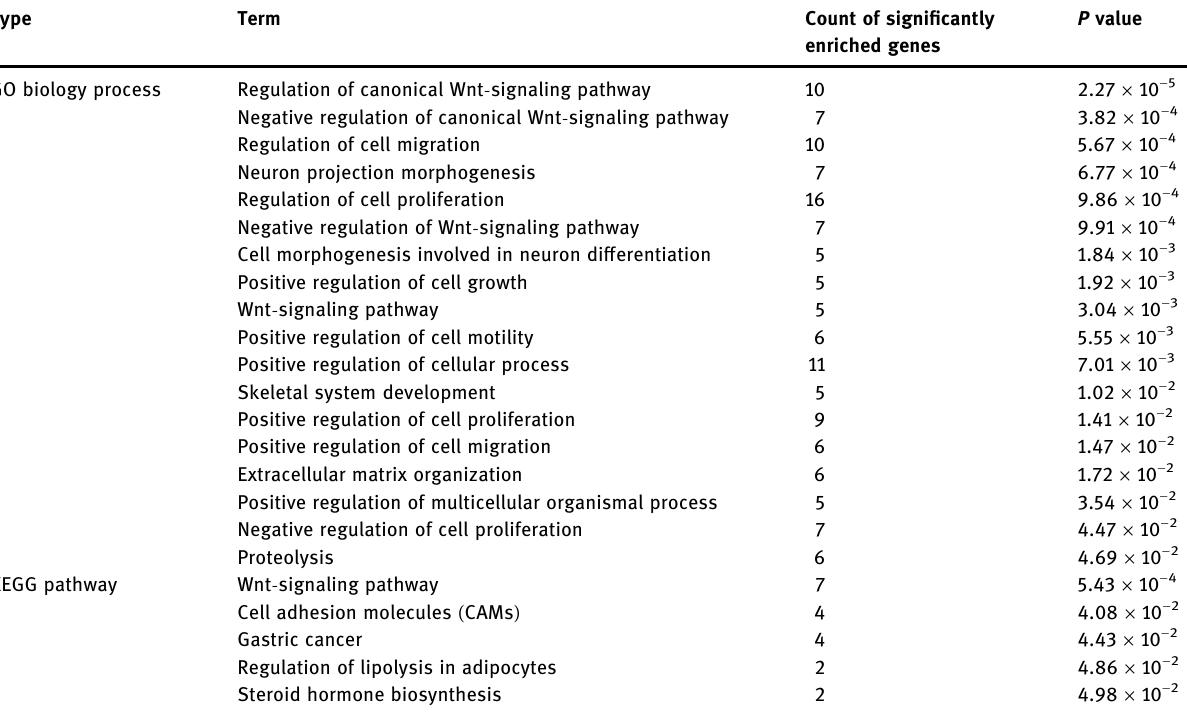
Table 3: Results of GO function and KEGG pathway enrichment analysis